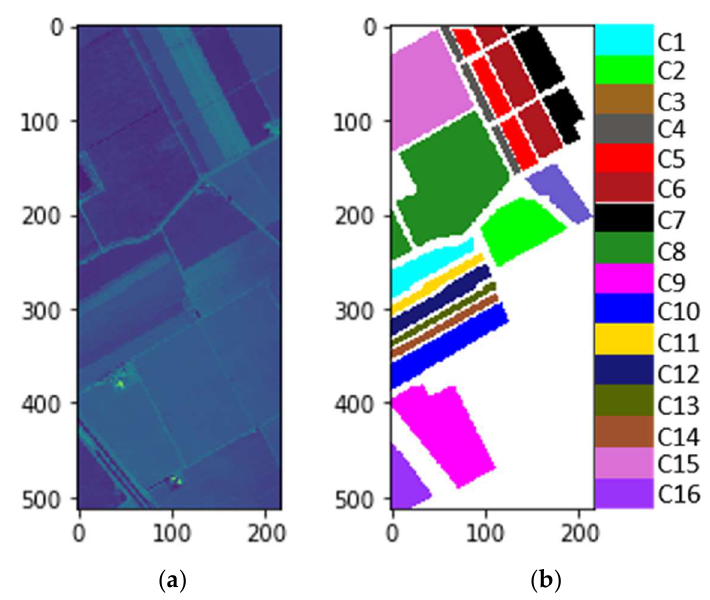
Figure 6. The Salinas image: ( a ) the 21th band image; ( b ) the ground truth of Salinas, where the white area represents the unlabeled pixels. Table 2. Salinas image: the number of samples per class.